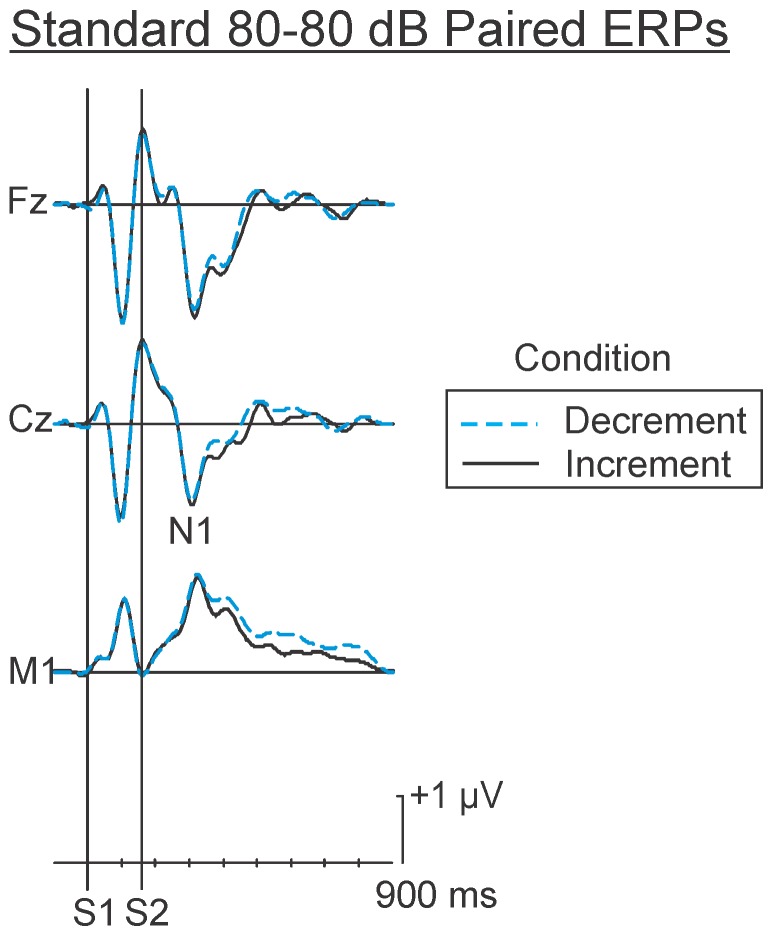
Grand average “raw” ERPs elicited by the standard pairs in the oddball conditions.In this and all other figures, positivity at the scalp relative to the reference is indicated by an upward deflection. The first 80–80 dB SPL standards in the increment and decrement conditions are superimposed. The morphology of these ERPs are essentially equivalent. Both include an N1s occurring approximately 100 ms followed by a positive deflection and another N1 approximately 140 ms following the onset of the second. These standard ERPs were subsequently subtracted from the ERPs elicited by the deviant 80–80 dB SPL pairs in the psychological increment and decrement conditions in order to isolate processing associated with the change detection process.